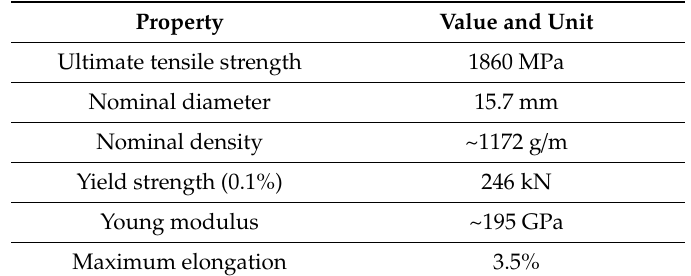
Table 3. Material characterization of prestressing reinforcement steel, parameters guaranteed by producer.